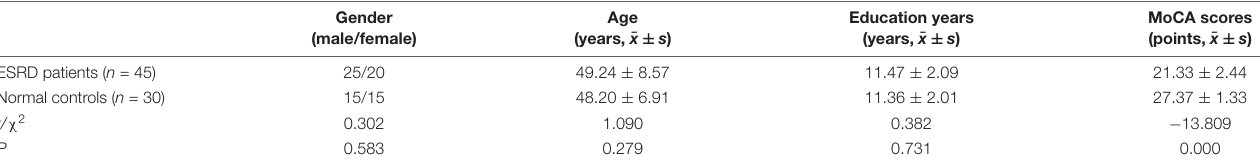
TABLE 1 | Demographic information of